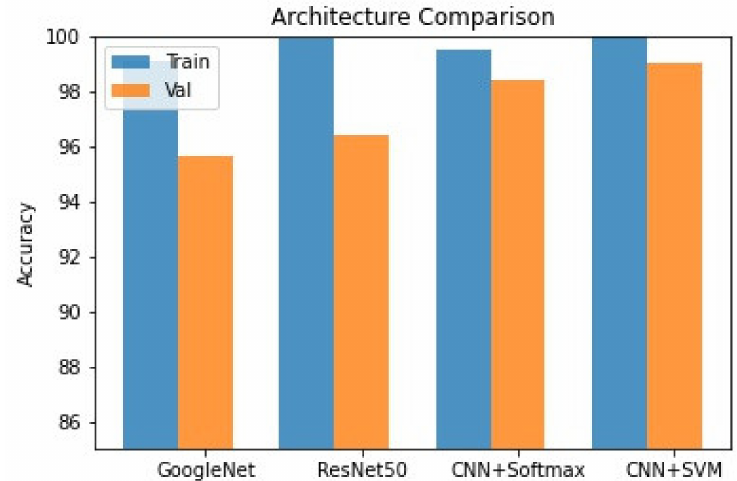
Figure 15. Comparison of accuracies on 4 proposed